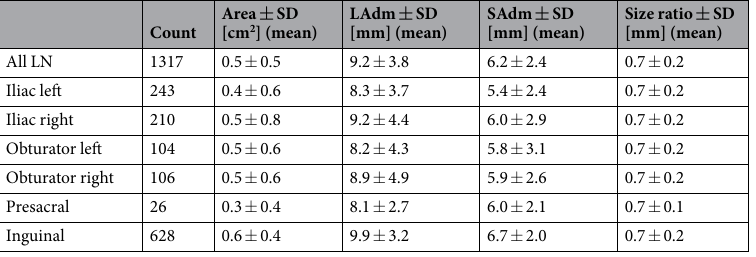
Table 1. Characteristics of all investigated lymph nodes in 68 Gallium-Prostate specific membrane antigen PET-CT. This table presents the main characteristics of all lymph nodes (LN) depicted in 68 Gallium-Prostate specific membrane antigen PET-CT including all benign and malignant LN. Count, area, long-axis diameter, short-axis diameter and size-ratio of the LN are presented in the columns. The size ratio is described as quotient of short-axis diameter divided through long-axis diameter. The rows show all LN together and fielded in the six defined anatomical regions iliac left and right, obturator left and right, presacral and inguinal region. Data are given in means and standard deviations. Abbreviations: LN = Lymph nodes, LAdm = Long-axis diameter, SAdm = Short-axis diameter, SD = Standard deviation.